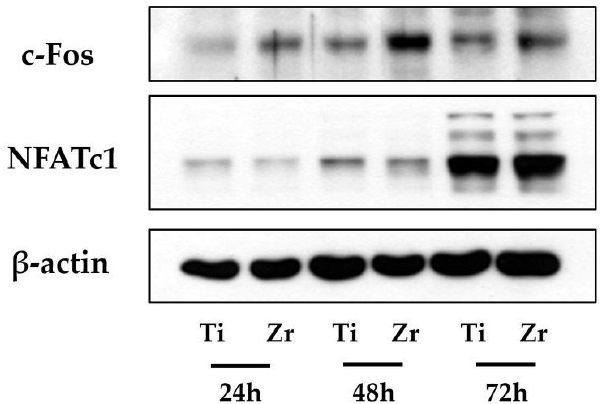
Figure 8. Protein levels of osteoclastogenic transcription factors in cells grown on Ti disks and zirconia disks were assayed by western blot analysis. Protein levels c-Fos on zirconia disks were thicker than Ti disks at day two. Protein levels of NFATc1 were not different across Ti and zirconia disks at any time point.